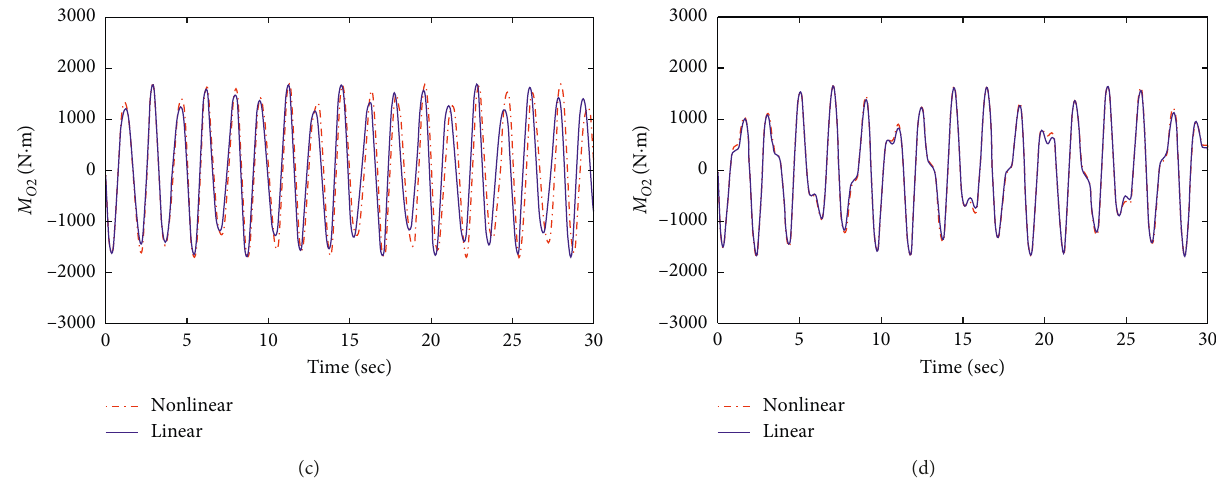
Figure 14: Time history of the resultant hydrodynamic moment about the θ � π /2 axis under the lateral harmonic excitation for r � 0 . 1 m (a), 0.3 m (b), 0.5 m (c), and 0.7m (d), respectively. and z 1 Table 3: The maximum amplitudes of the nonlinear response versus the inner radius of the baffle for z Maximum amplitudes of the nonlinear response